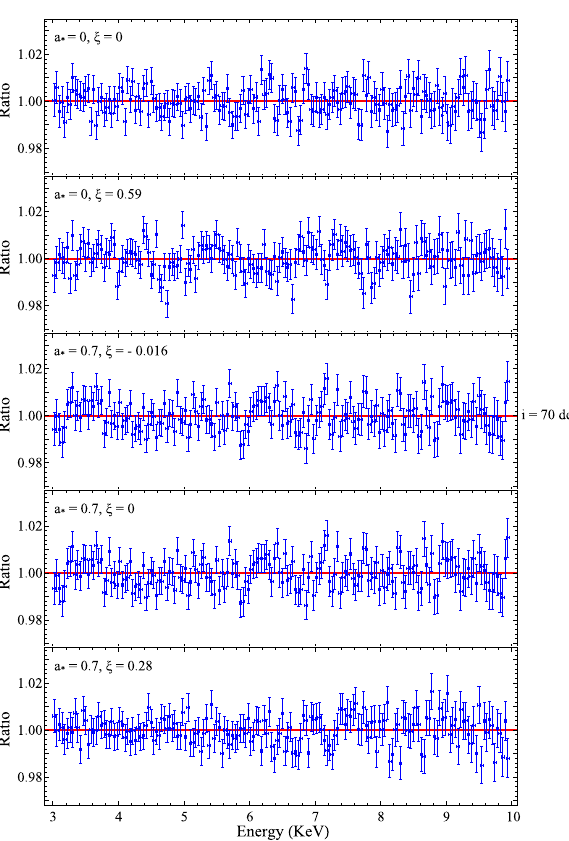
Fig. 4 Ratio data/best-fit model for simulations 1–5. See the text for more details